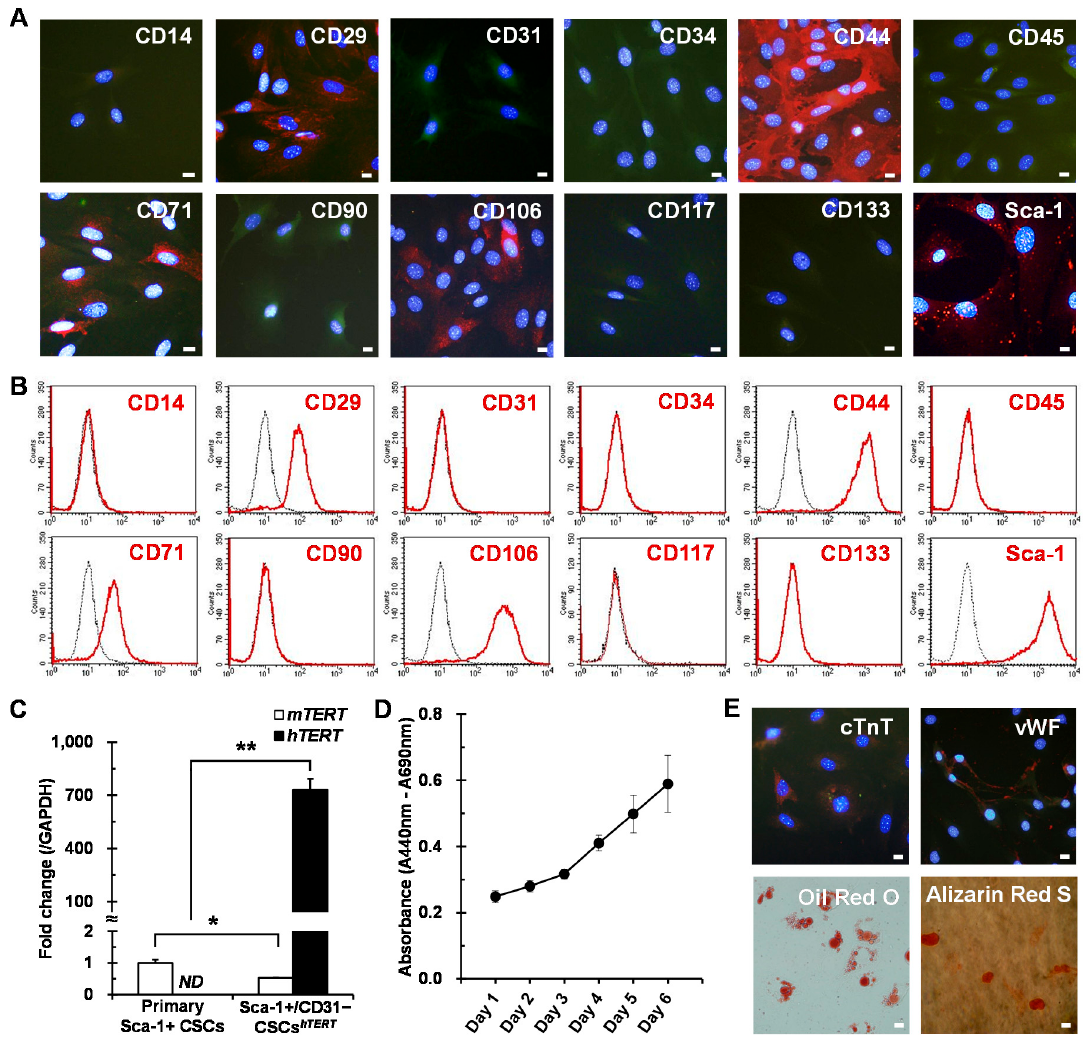
Figure 3. Sca-1+/CD31 − CSCs hTERT exhibit stem cell potency. For phenotypic characterization, Sca-1+/CD31 − CSCs hTERT expressing GFP (green) were analyzed by immunostaining ( A ) and flow cytometry ( B ) with different cell surface antibodies (red); ( C ) real-time PCR was performed to detect both endogenous mTERT and transduced hTERT transcripts in primary Sca-1+ CSCs and immortalized Sca-1+/CD31 − CSCs hTERT . Data represent mean ± SD from three independent experiments (* p < 0.05; ** p < 0.01). ND , not determined; ( D ) for proliferation analysis, Sca-1+/CD31 − CSCs hTERT were seeded at 1 × 10 3 cells/well in 96-well microplates, cultured with Mesencult Basal Medium supplemented with cytokines for six days, and analyzed by WST-1 assay. Data represent mean ± SD from four independent experiments; and ( E ) Sca-1+/CD31 − CSCs hTERT exhibit multi-differentiation potential. Differentiation was analyzed by immunostaining with a cardiomyocyte marker (cTnT, red), an endothelial marker (vWF, red), and by Oil-Red O staining (red) or Alizarin Red S staining (red). Nuclei were stained with DAPI (blue). Scale bars = 20 µm.